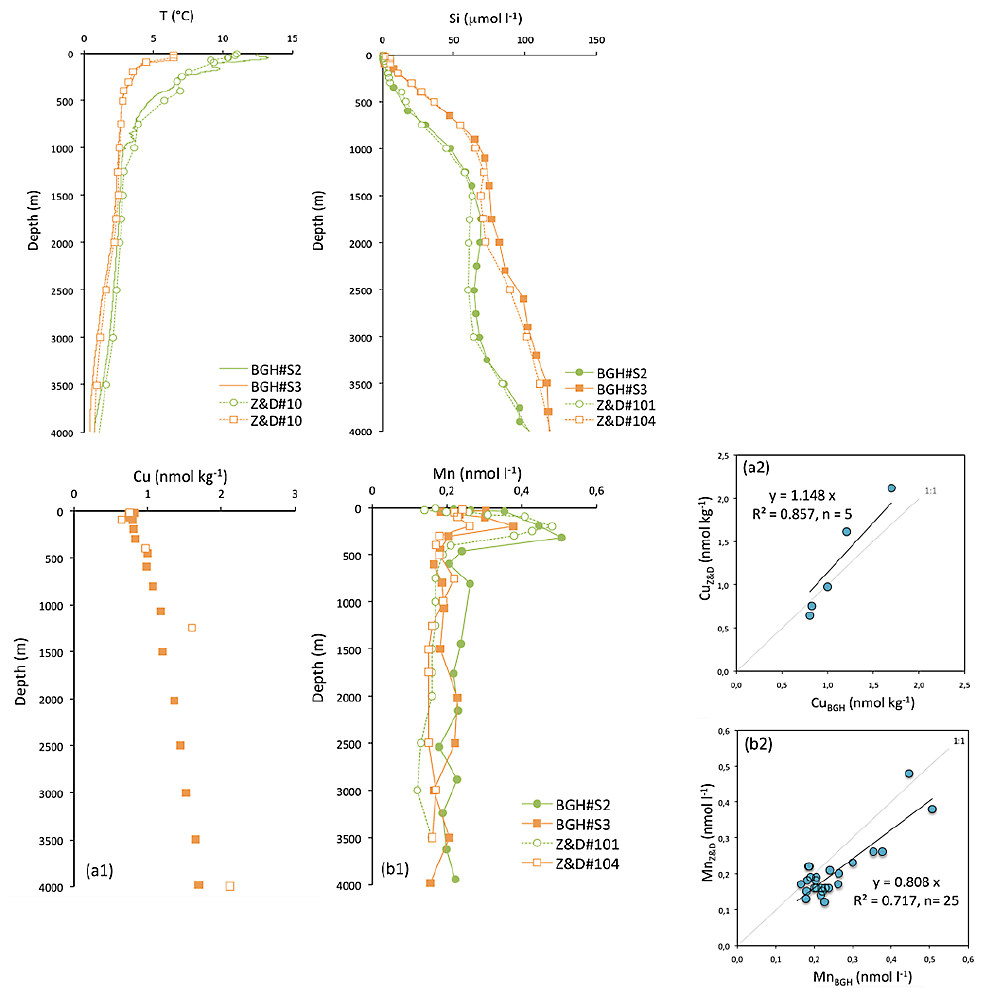
Fig. 5. Comparison of the vertical profiles of temperature ( ◦ C) and silicate concentrations (µM) (top panel), and of dissolved copper (a1) and manganese (b1) concentrations at the two crossover stations of the MD166 BONUS-GoodHope cruise (BGH#S2 at 42.47 ◦ S, BGH#S3 at 47.55 ◦ S) and the ANT XXIV/3 cruise (Z&D#101 at 42.34 ◦ S, Z&D#104 at 47.66 ◦ S) along the Greenwhich Meridian. Linear regression between the two datasets of copper concentrations (a2) (in nmolkg − 1 ) and of manganese concentrations (b2) (in nmoll − 1 ) obtained at the crossover stations (the Z&D dataset of Mn is from Middag et al., 2011a, and of Cu from Heller et al.,